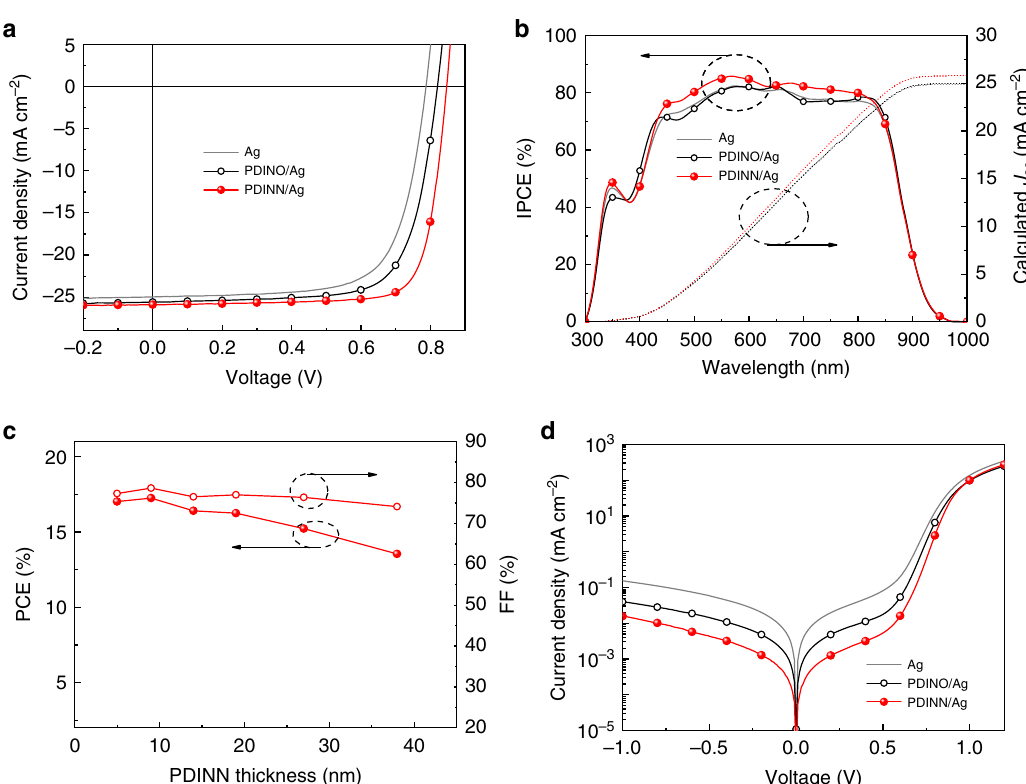
Fig. 2 Device performance of the OSCs based on PM6:Y6 with Ag as cathode. a J – V curves of the best OSCs under the illumination of AM 1.5 G, 100 mWcm − 2 . b IPCE spectra and integrated current density of the best devices. c Dependence of PCE and FF of the OSCs on the thickness of PDINN CIM. d Dark currents of the